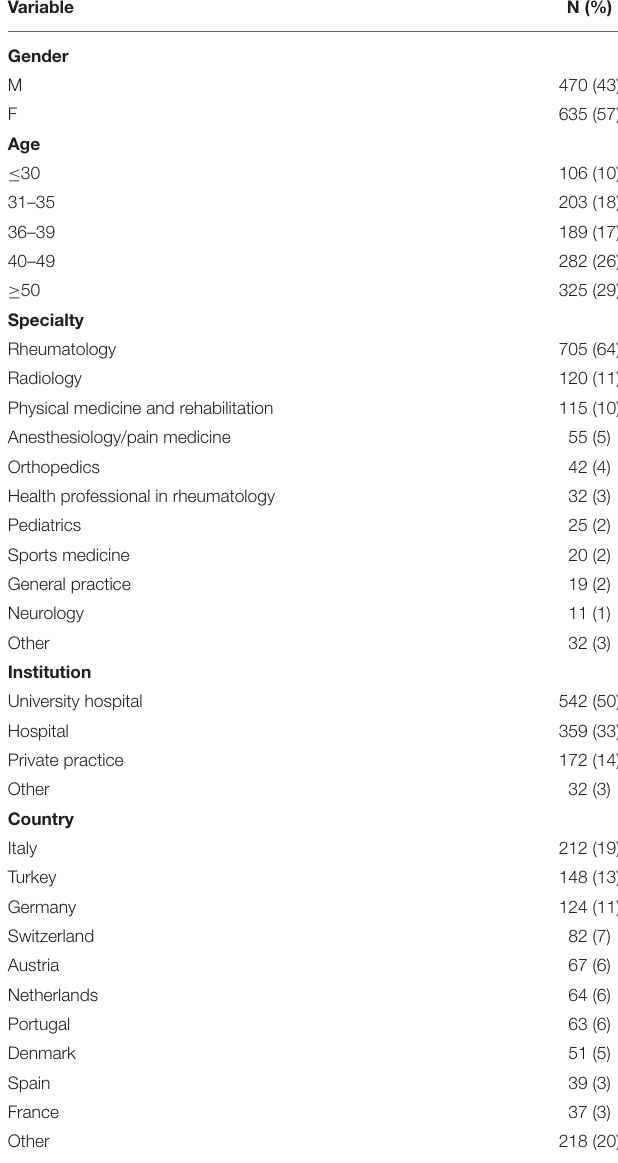
TABLE 1 | Characteristics of survey respondents ( N =